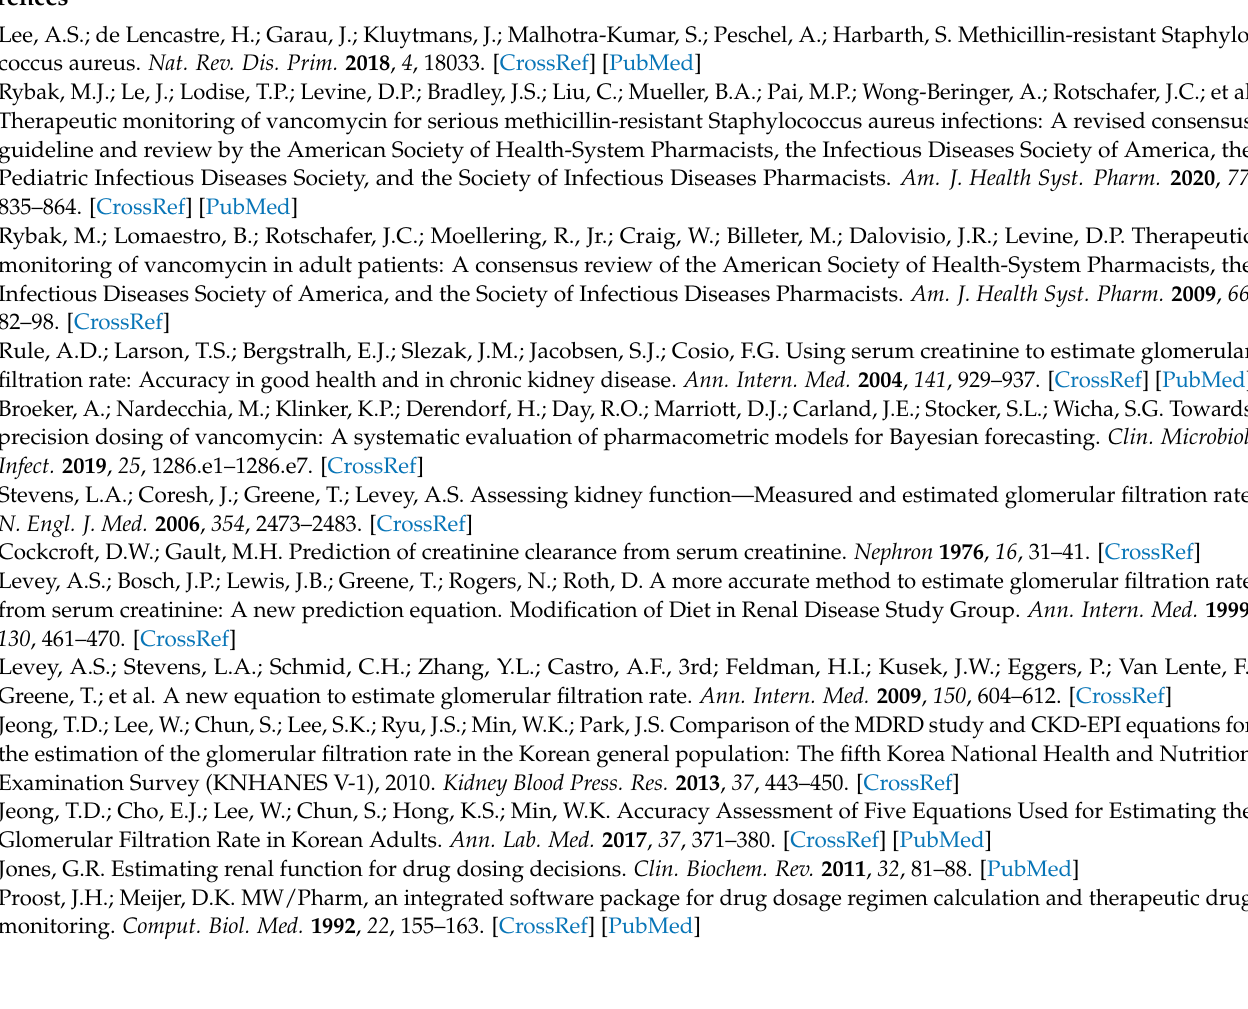
Figure A1. Bland–Altman plots for AUC 24 of vancomycin according to estimated glomerular filtration rate equations. ( A ) Between C-G and MDRD. ( B ) Between C-G and CKD-EPI. ( C ) Between C-G and revised LM. Arrows indicate outliers. Abbreviations: AUC, area under the curve over 24 h; C-G, Cockcroft-Gault; CKD-EPI, Chronic Kidney Disease Epidemiology Collaboration; MDRD, Modification of Diet in Renal Disease; LoA, limit of agreement; and LM, Lund–Malmö.